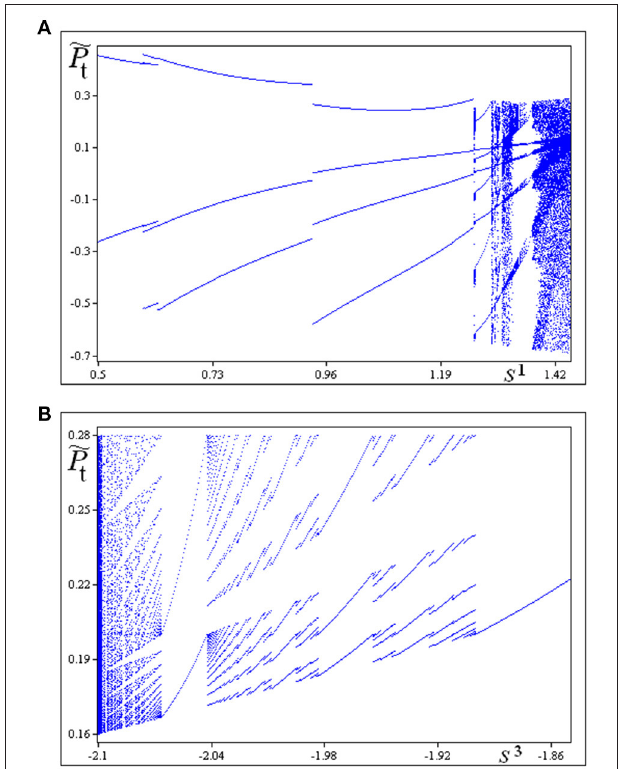
FIGURE 5 | In (A) bifurcation diagram with respect to s 1 , while in (B) with respect to s 3 . The other parameters are the same used for Figure 4